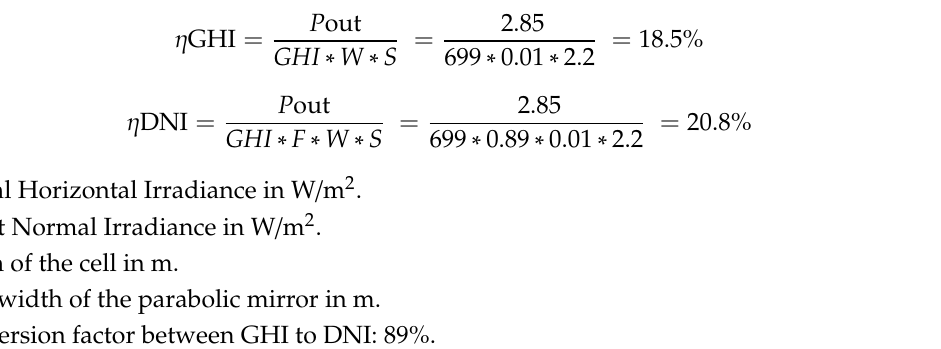
Figure 18. Clearly visible line focus on the absorber tube during the measurements. It can be seen that the line focus is exactly on the solar cell. The challenge for the tracking system is to achieve this permanently.